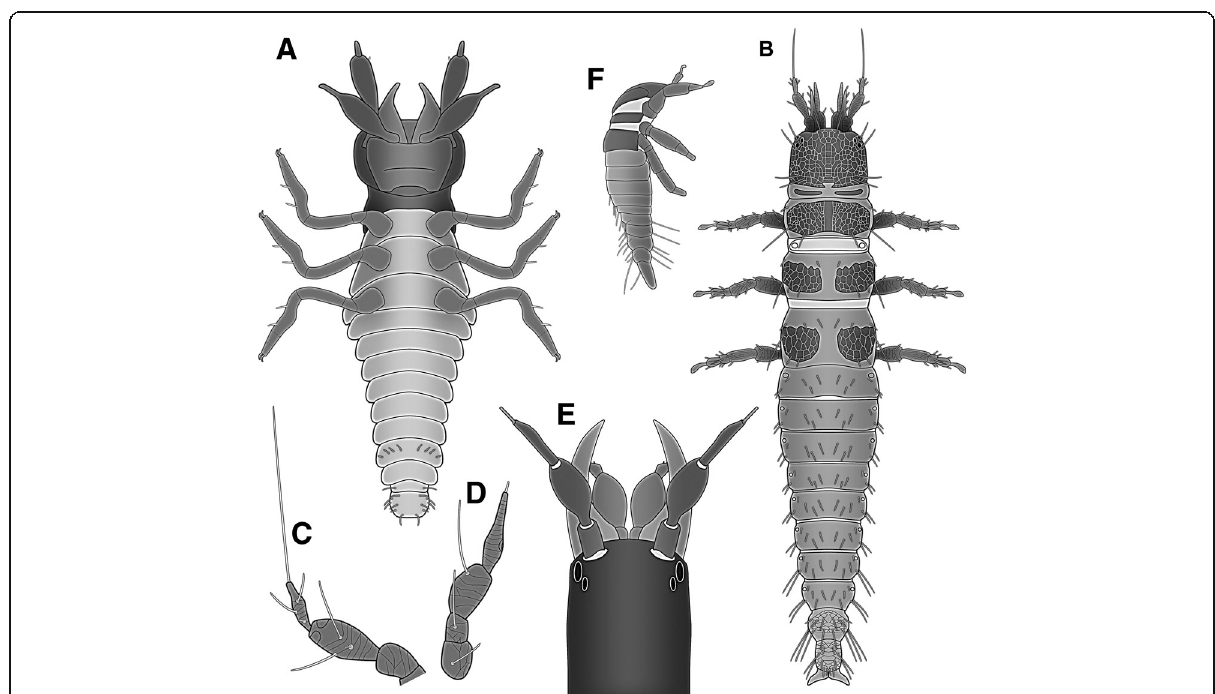
Fig. 3 Restoration of the fossil mantis lacewing larva and comparative material of different representatives of Mantispidae. a Restoration of the new fossil larva in ventral view. b First larval stage of the extant species Mantispa uhleri ; simplified from [5] (their Fig. 4A). c , d . Antenna ( c ) and labial palp ( d ) of first larval stage of the extant species Mantispa pulchella ; simplified from [14] (their Fig. 15). e Head of Plega melitomae ; note the curved mandibles; modified after [15] (his Fig. 42). f Fossil mantis lacewing larva described by Ohl [1]; simplified from [1] (his Fig.